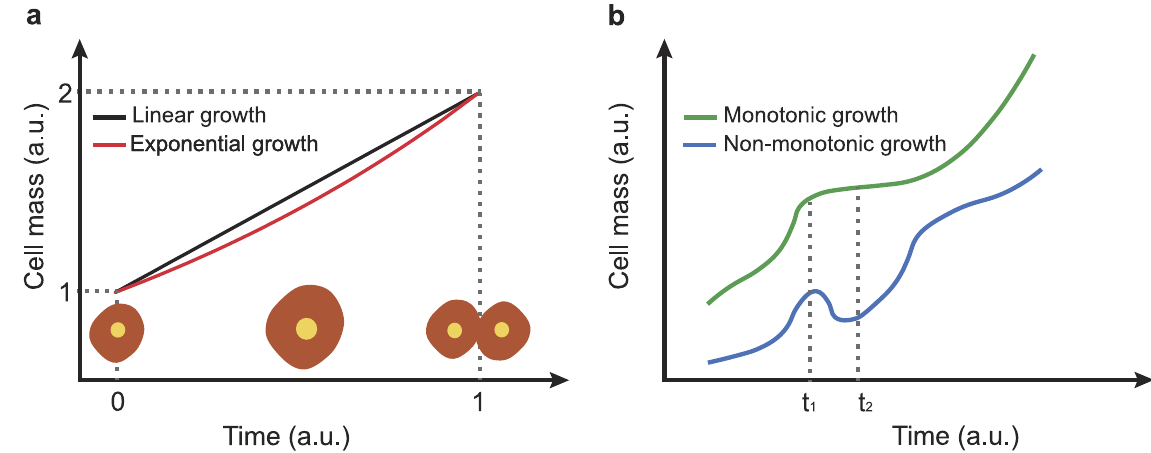
Figure 1 Cell mass and growth. a Representation of a cell changing its mass throughout the cell cycle following traditional models. The black curve shows a linear growth and the red curve shows an exponential growth. The cell eventually divides into two daughter cells. b Examples of monotonic and non-monotonic mass growth behaviours. A monotonic increasing (decreasing) behaviour means that a cell’s mass at any given time, t central models in ( a ) imply a monotonic mass increase. Recently identified mass fluctuations [25] in mammalian cells challenge